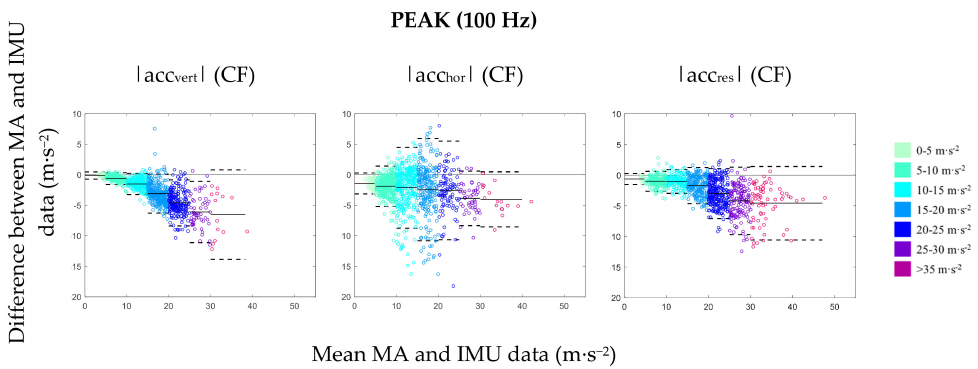
Figure 4. Bland–Altman plots showing the relationship between MA system data and CF data for peak values of | acc res | , | acc hor | , and | acc vert | . Magnitude values for each trial were categorized according to pre-defined acceleration bands. For each acceleration band, 95% LoA (dashed line) and mean bias (solid line) are displayed with reference to zero (black solid line).